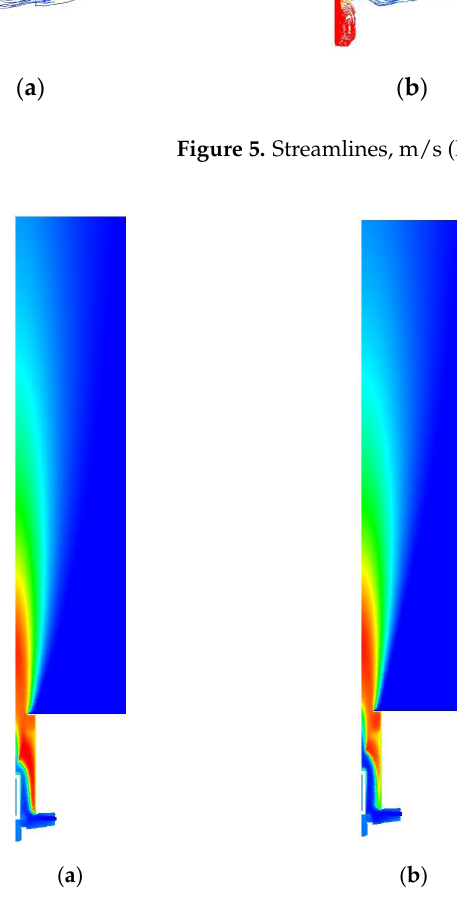
Figure 6. Temperature in the burnet and at its outlet, °C: ( a ) k-e; ( b ) k-w SST; ( c ) RSM.